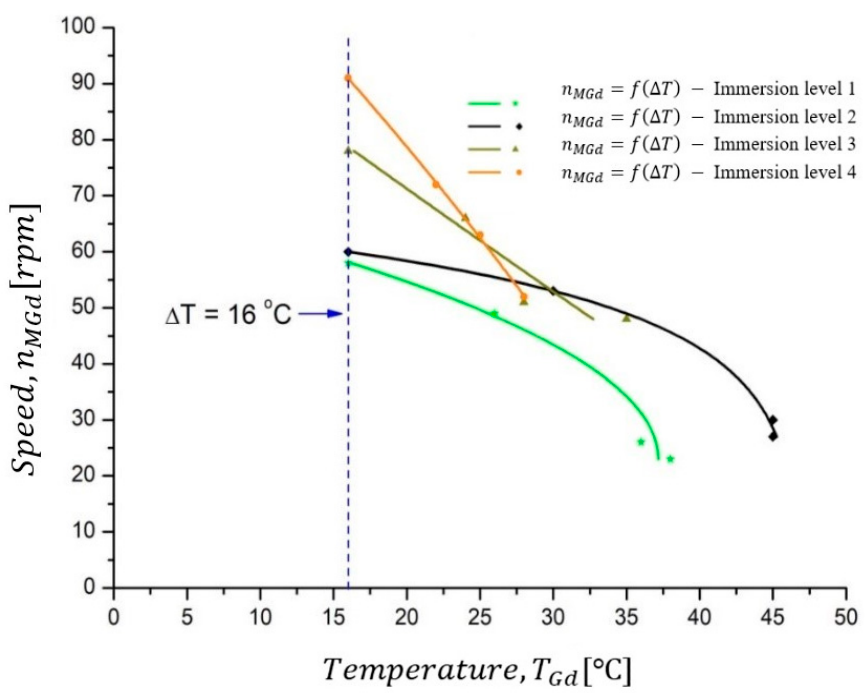
Figure 10. Variation of gadolinium motor speed as a function of temperature difference ∆ T, as a result of the change in the number of gadolinium pills immersed in the volume of water.